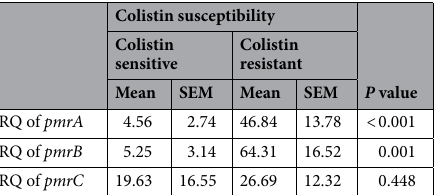
Table 2. Expression levels of pmrA , pmrB , and pmrC in colistin-susceptible and colistin-resistant isolates. RQ relative quantification, SEM standard error of